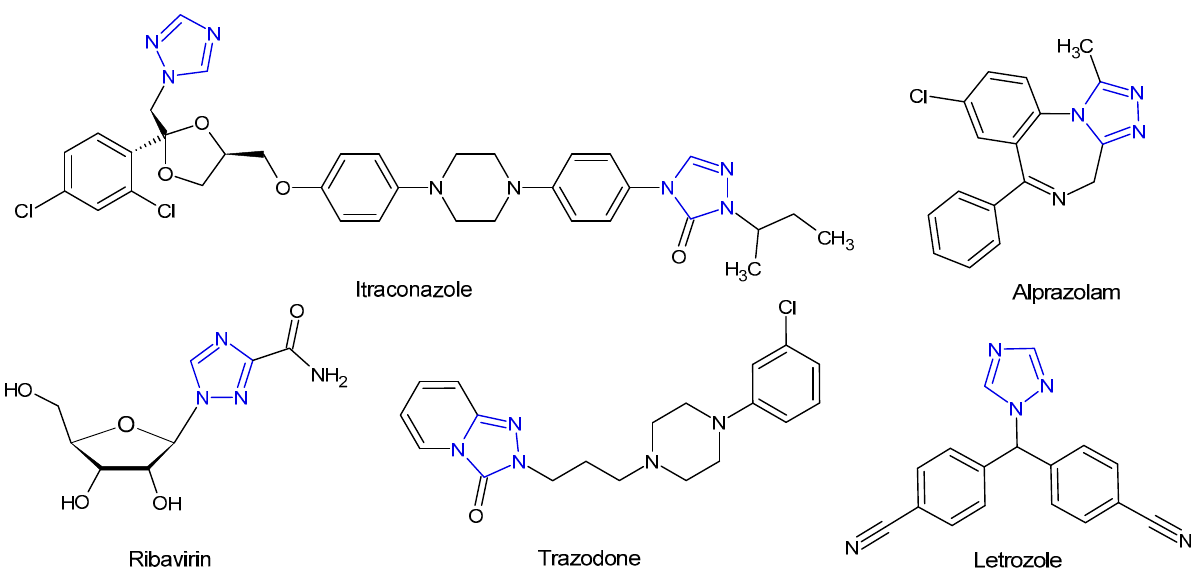
Figure 2. Selected 1,2,4-triazole drugs.